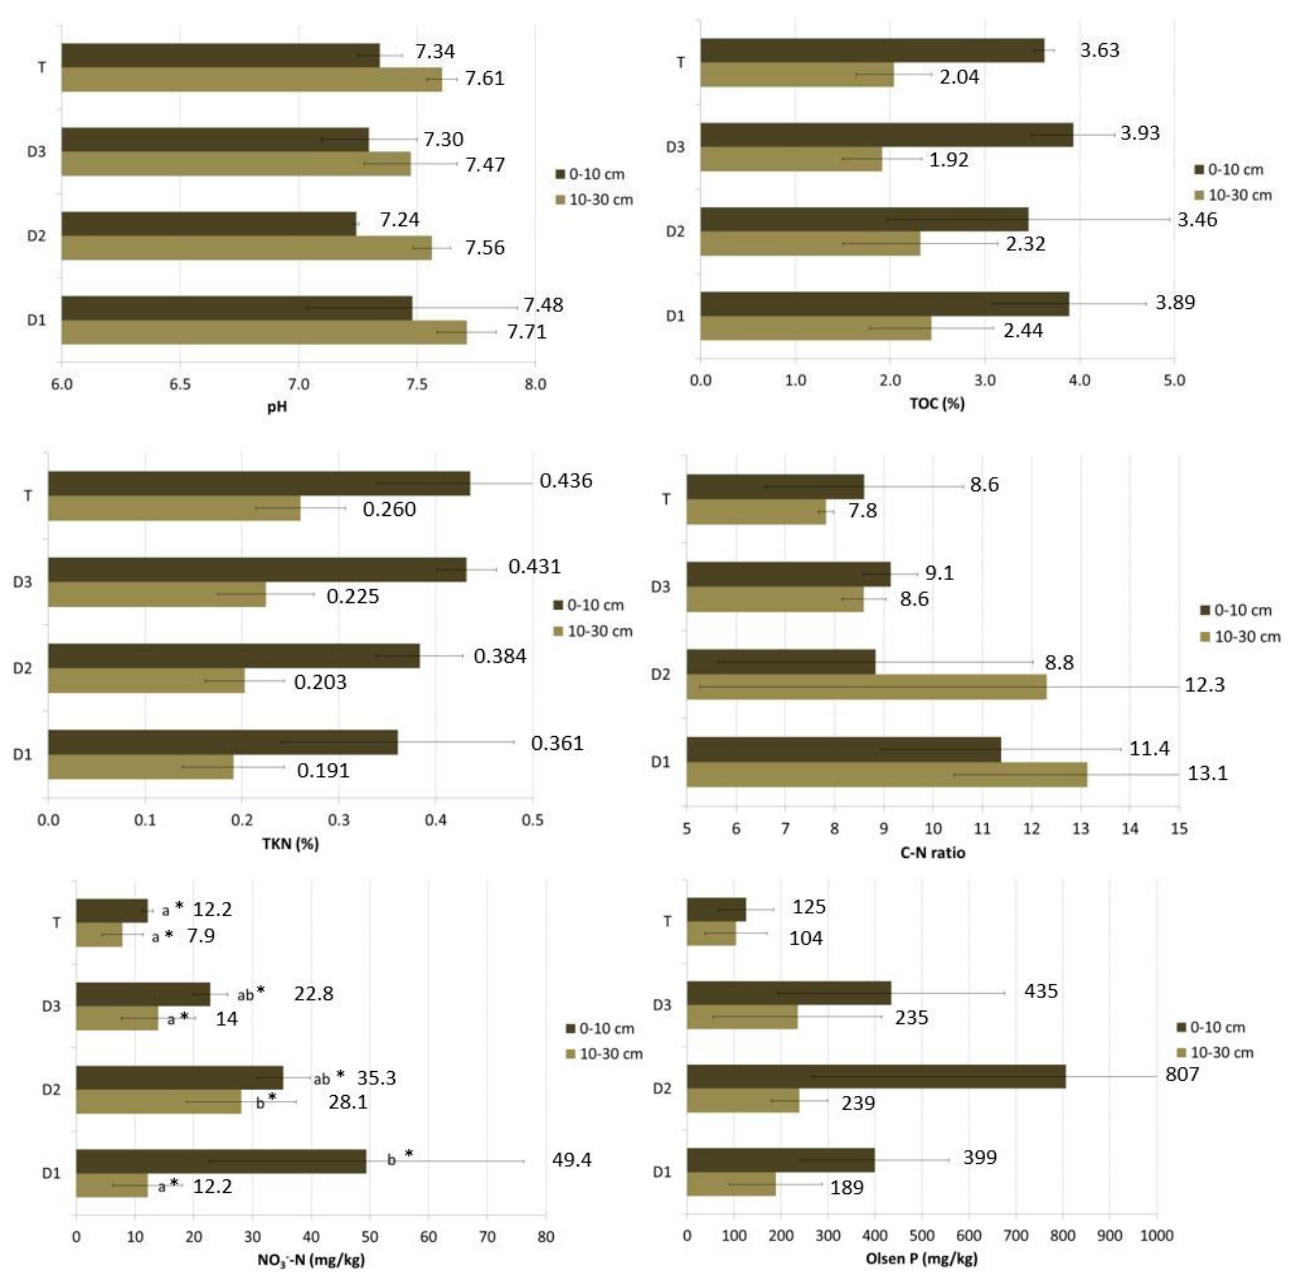
Figure 1. Average values and standard deviation for each sampling position and depth (FA). Different letters correspond to statistically significant differences among the means of measurements of the same depth at different distances. * significant at p ≤ 0.05 according to ANOVA-test.